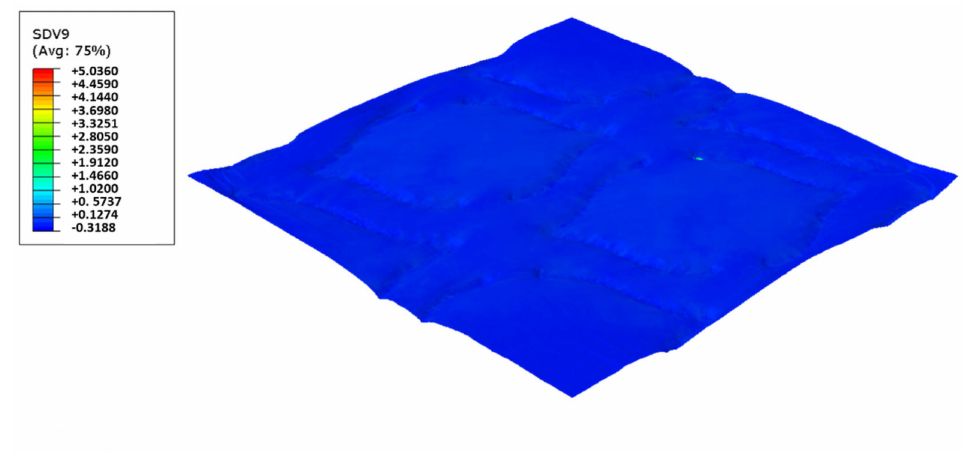
Figure 23. Deco die 75_48 Sh-A (CR PR/NR BG), Plastic field.